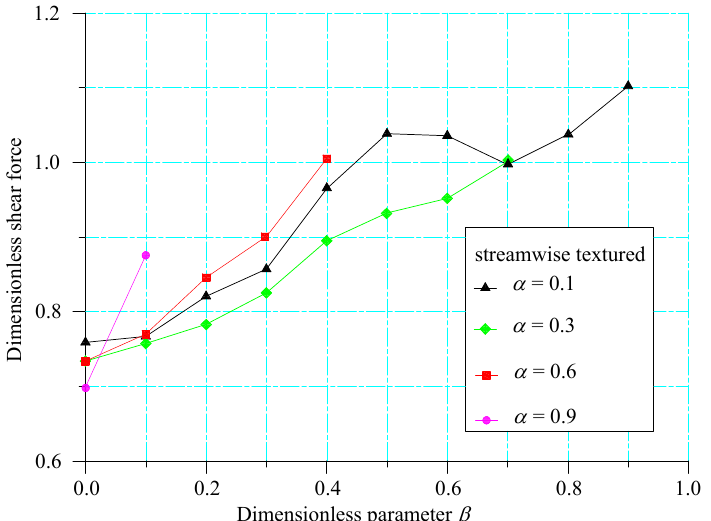
Figure 17. The influence of the position of the streamwise texture on the dimensionless shear force on the moving